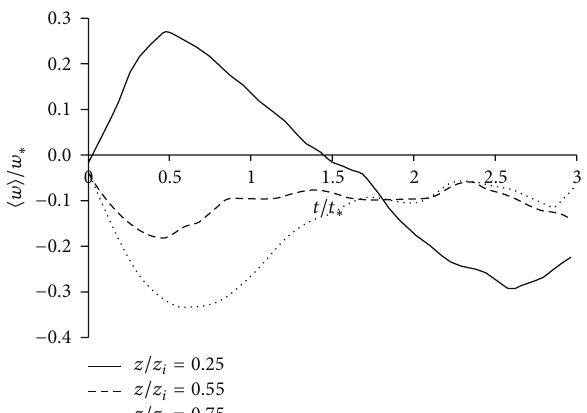
Figure 9: Mean vertical velocity component as a function of time in the Lagrangian reference frame at three nondimensional heights.